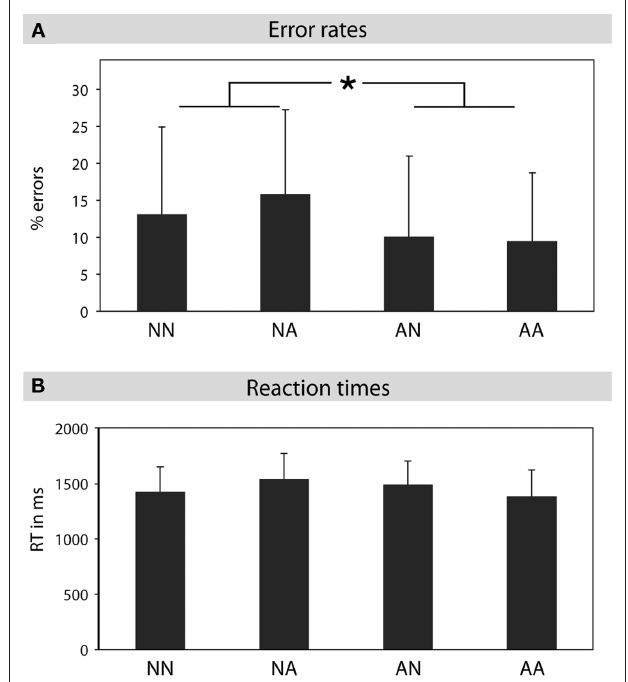
FIguRE 2 | Behavioral data. (A) Error rates for the processing of double negations (NN), negations in the main clause (NA), negations in the subordinate clause (AN), and affirmations (AA). The two conditions with negations in the main clause (NN, NA) produced slightly more errors than the two conditions with affirmations in the main clause (AN, AA). (B) Reaction times for the processing of double negations (NN), negations in the main clause (NA), negations in the subordinate clause (AN), and